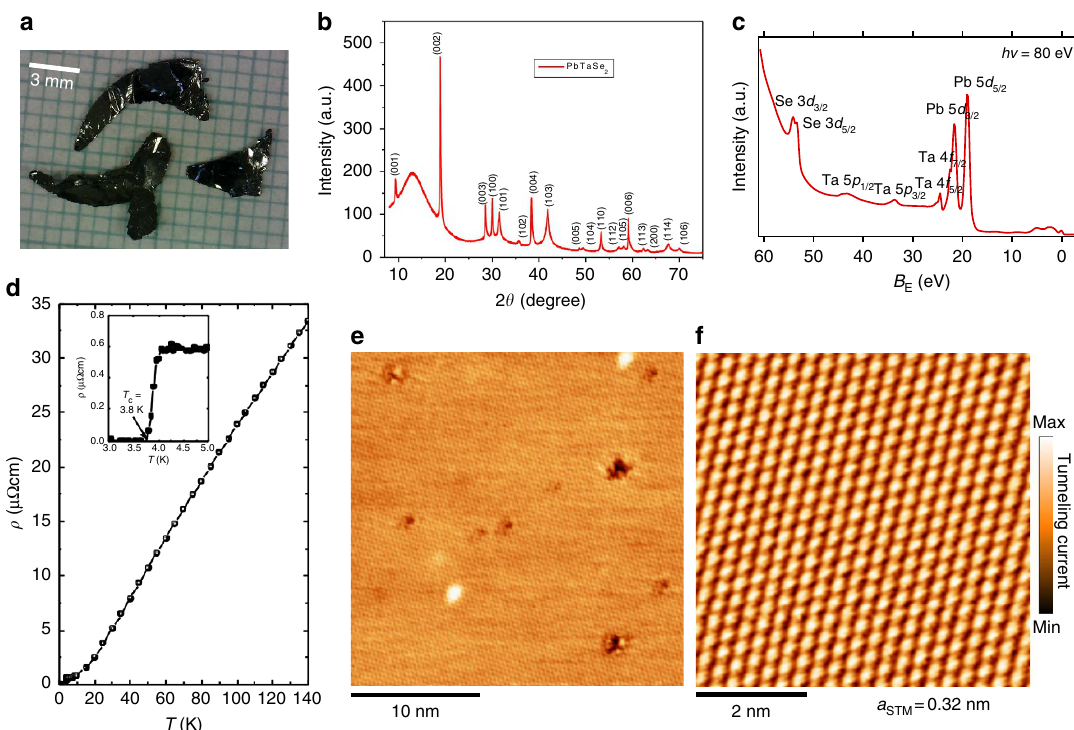
Figure 1 | Overview of PbTaSe 2 single crystal. ( a ) Optical image of PbTaSe 2 single crystals measured in this work. ( b ) X-ray diffraction measurements showing the lattice parameters matching with the space group (187) P (cid:2) 6 m 2. ( c ) ARPES core-level spectrum showing clear Pb-5 d , Se-3 d and Ta-4 f core-level peaks. ( d ) Resistivity as a function of temperature showing a superconducting transition at 3.8K. ( e , f ) STM topography of PbTaSe 2 , indicative of a surface lattice constant